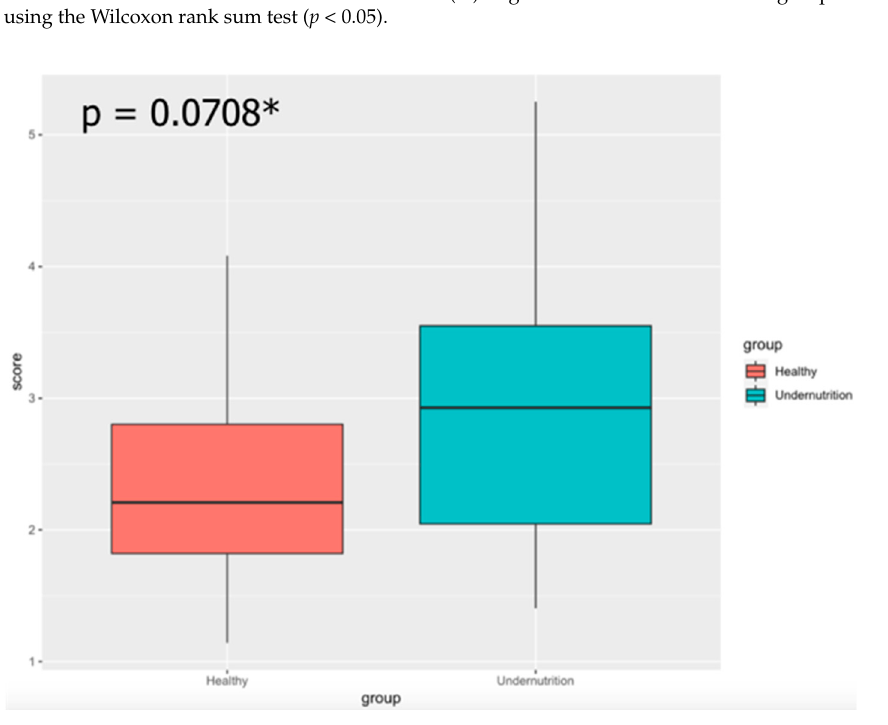
Figure 2. Ratio of Firmicutes to Bacteroidetes. Significant differences between groups were calculated using the Mann–Whitney U test (* p < 0.1).